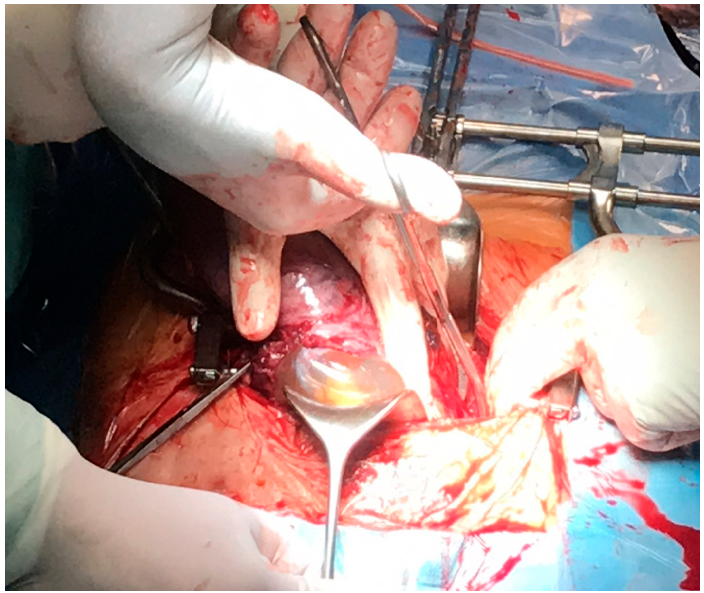
Figure 5. Intraoperative image after the separation of the peritoneum from the anterior wall of the uterus.